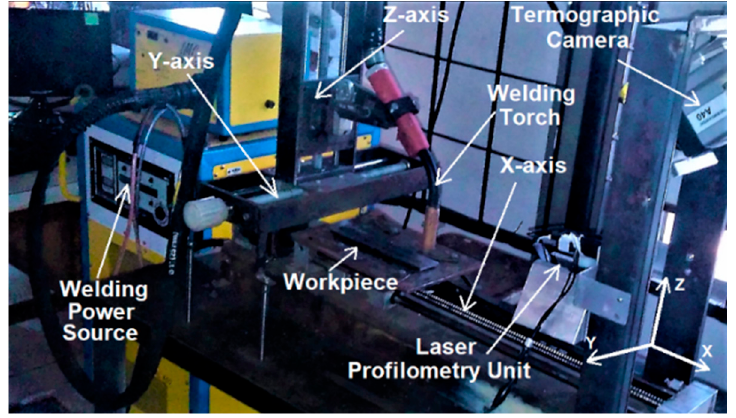
Figure 1. Robotic welding table with welding power source and thermographic camera.